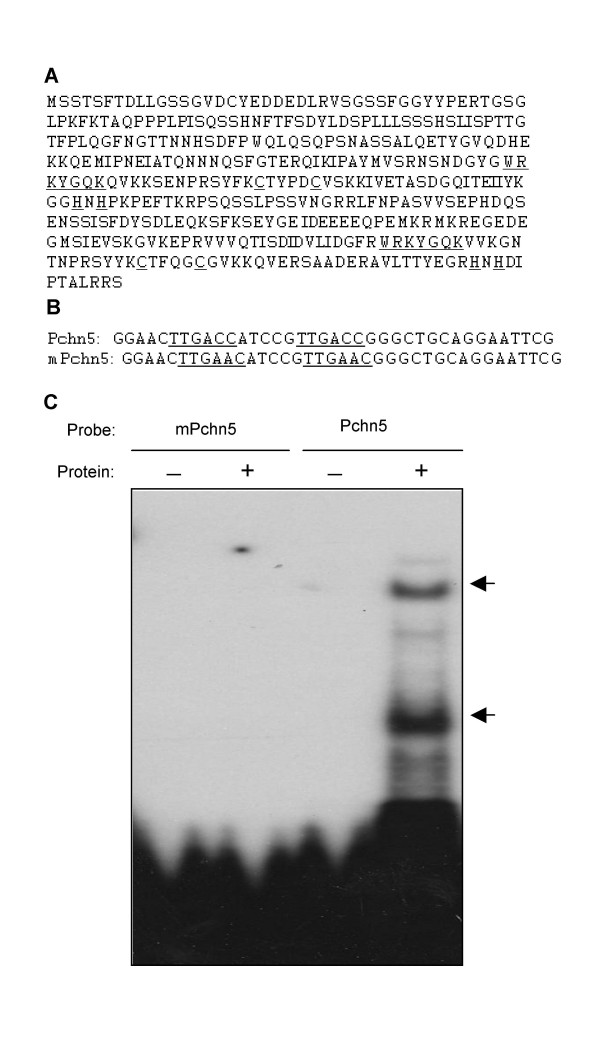
Sequence and DNA-binding Activity of WRKY25. A. Amino acid sequence of WRKY25. The two WRKY motifs are indicated with the highly conserved WRKYGQK sequence and the residues forming the C2H2 zinc fingers underlined. B. Oligonucleotides used in the electrophoretic mobility shifting assay (EMSA). The Pchn5 probe contains two direct W-box repeats, while in the mPchn5 probe, the TTGACC sequences are mutated to TTGAAC. The wild-type and mutated W-box sequences are underlined. C. EMSA to test binding of recombinant WRKY25 to the W box motif in the Pchn5 probe. Binding reactions containing WRKY25 and Pchn5 produced two major DNA/protein complexes, which are indicated by arrows. Change of the TTGACC to TTGAAC in the mPchn5 probe abolished WRKY25 binding. No retarded bands were detected in the absence of the recombinant WRKY25 protein.